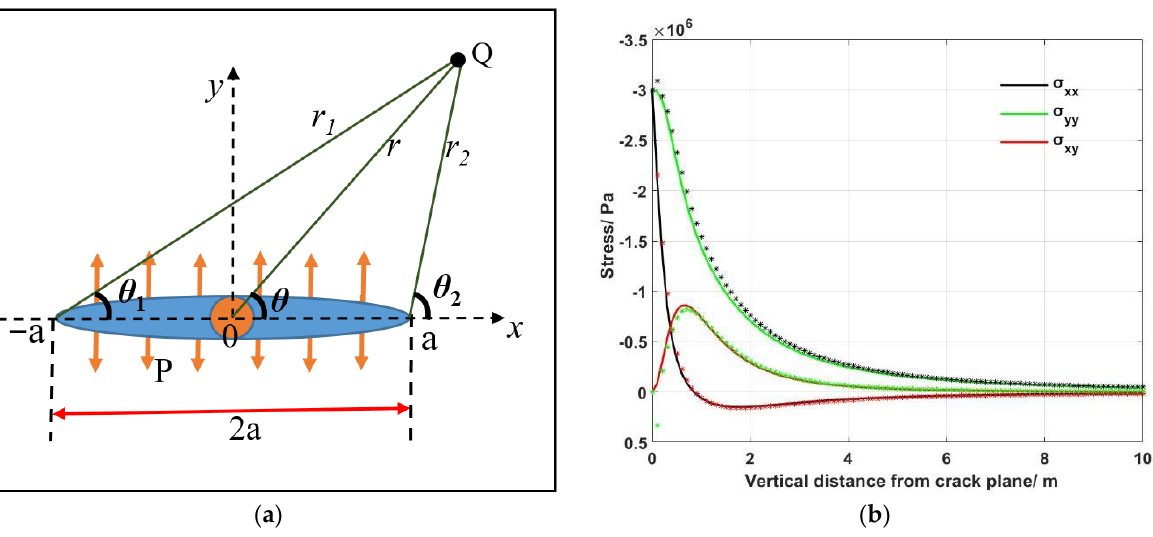
Figure 3. The mechanical model. Where: θ is the angle between fracture and the uniaxial tensile force P .